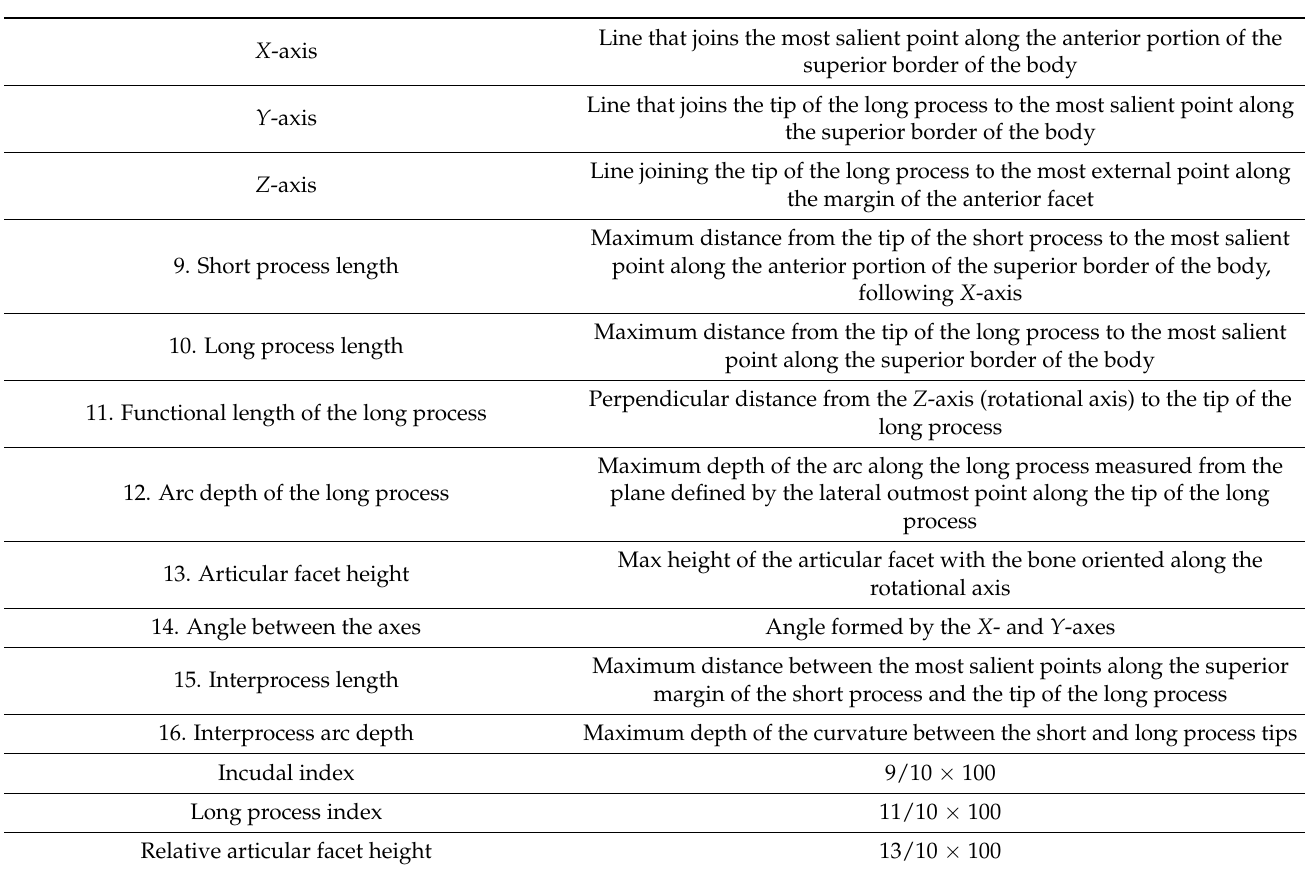
Table 2. Measurement protocol and indices for the incus [5].